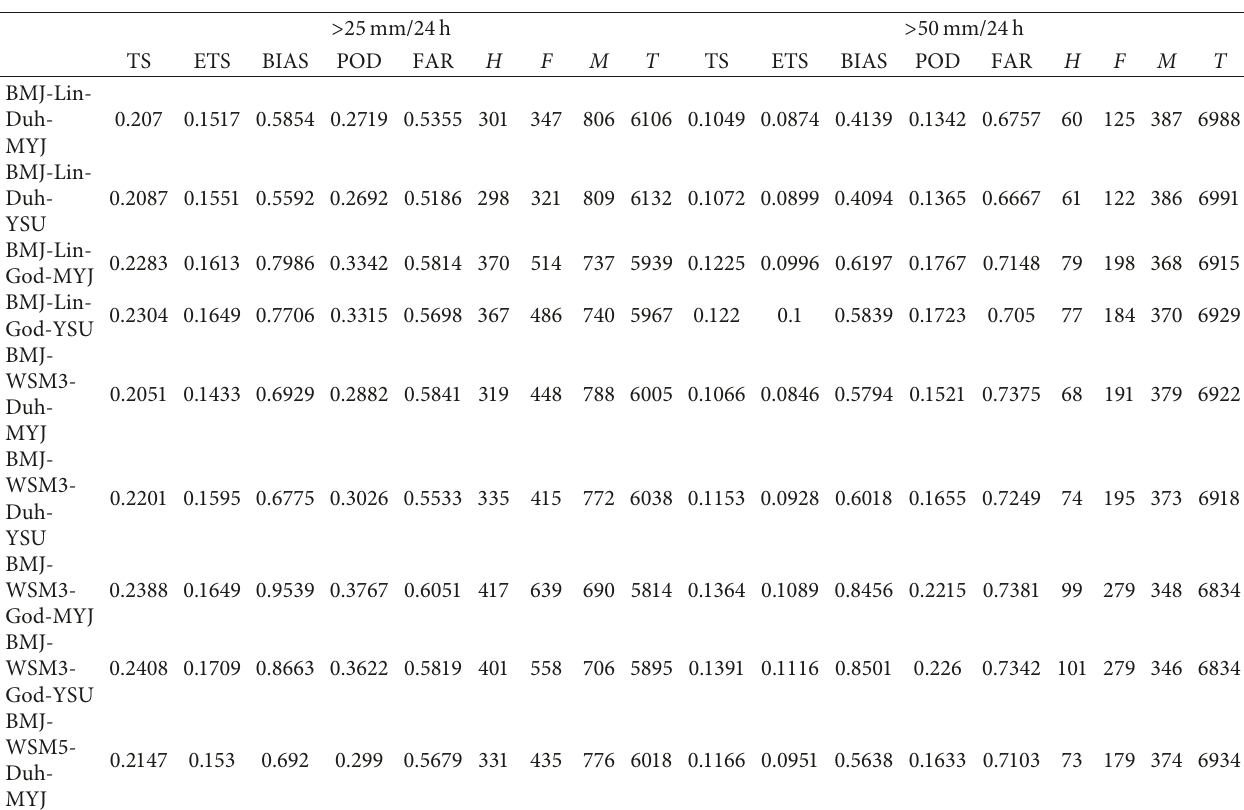
Table 4: Skill scores (TS, ETS, BIAS, POD, and FAR) and hit rates H , false alarm rates F , missed rates M , and total corrected rates T at the 24h forecast range for thresholds > 25mm/24 h and > 50mm/24 h, for the period 2012–2016. The number of samples is